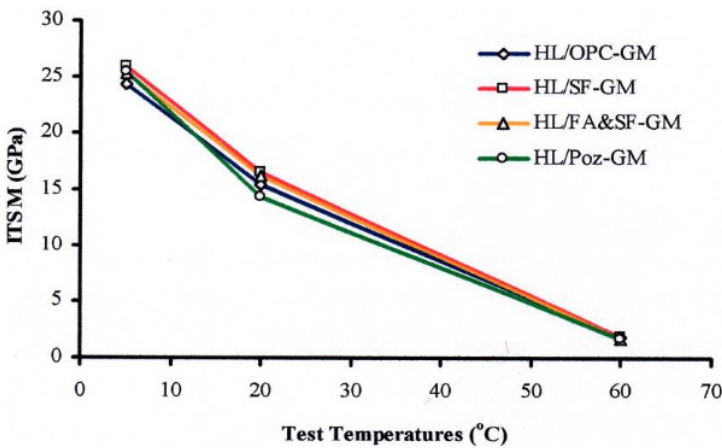
Figure 5. Effect of cementitious grout on the tensile modulus of elasticity [50].